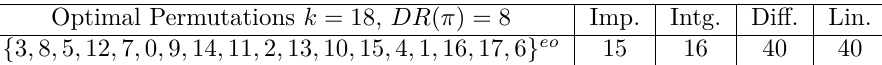
Table 17: Optimal permutations for k = 18 up to extended pair-equivalence Optimal Permutations k = 18, DR ( π ) = 8 Imp. Intg. Diff.